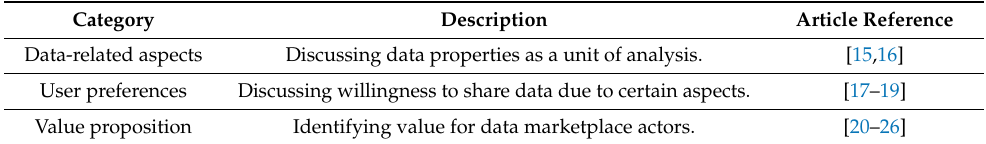
Table 2. The service